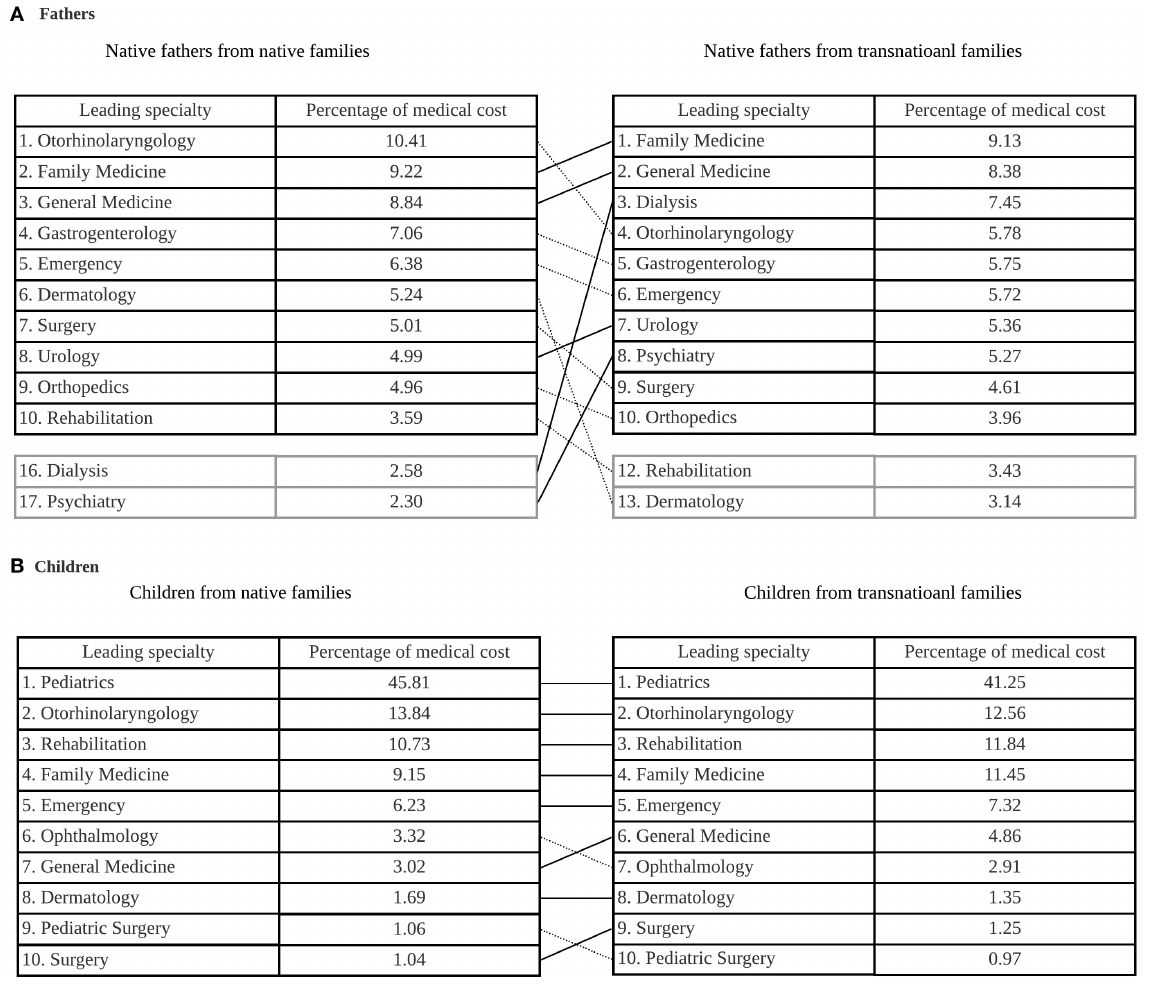
FIGURE2 Ten leading medical specialties by total inflation-adjusted medical cost from 2004 to 2017 and percentage difference for fathers from native families and native fathers from transnational families (A) and children from native families and children from transnational families (B)